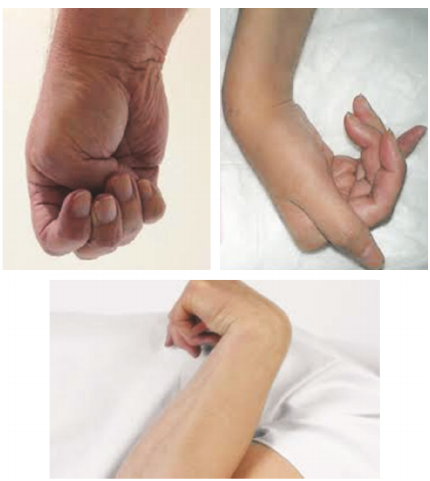
Figure 1: Some examples of spastic hands evidencing